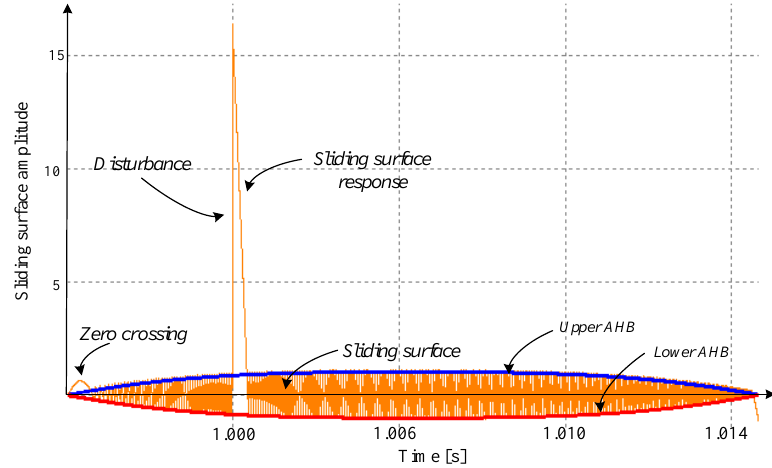
Figure 15. Sliding surface response for load increase.